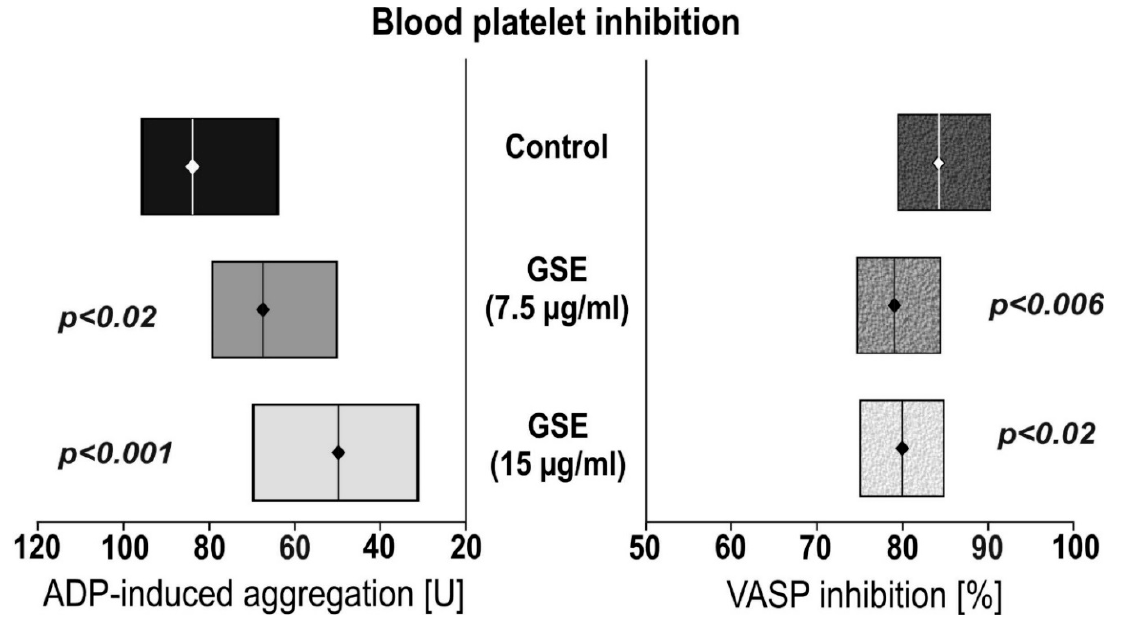
Figure 1. The effect of grape seed extract (GSE) on adenosine diphosphate (ADP)—induced aggregation and VASP inhibition. Aggregation was made using multiple electrode aggregometry (MEA). Vasodilator-stimulated phosphorylation (VASP) inhibition was conducted using flow cytometry. Data are presented as a median (interquartile range: LQ-UQ). The significance of the differences was analyzed using a Mann-Whitney U test.